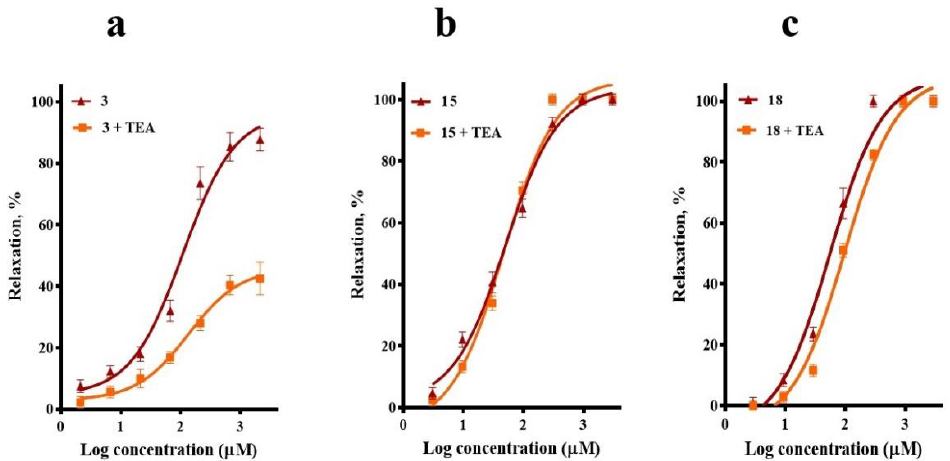
Figure 6. Vasodilatory effect of ( a ) corosolic acid ( 3 ), ( b ) meso -dihydroguaiaretic acid ( 15 ), and ( c ) 5,8,4′-trihydroxy-3,7-dimethoxyflavone ( 18 ) in the absence (control) and presence of tetraethylammonium (TEA, 10 mM). Analysis by one-way ANOVA was made between the curves of each compound in the absence and presence of TEA followed by a post hoc Tukey’s test ( 3 , p < 0.0001; 15 , p = 0.868; 18 , p = 0.429).